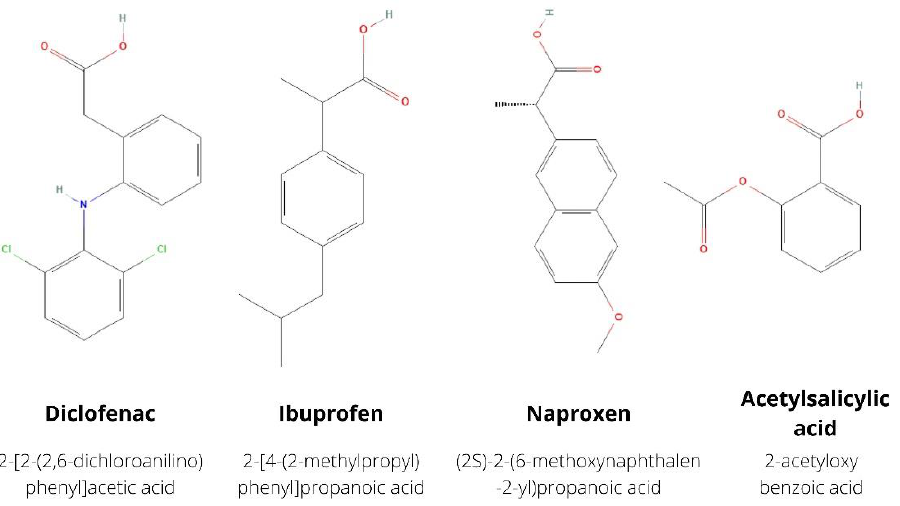
Figure 1. The structures of described in this review non-steroidal anti-inflammatory drugs (NSAIDs) with International Union of Pure and Applied Chemistry (IUPAC) name.